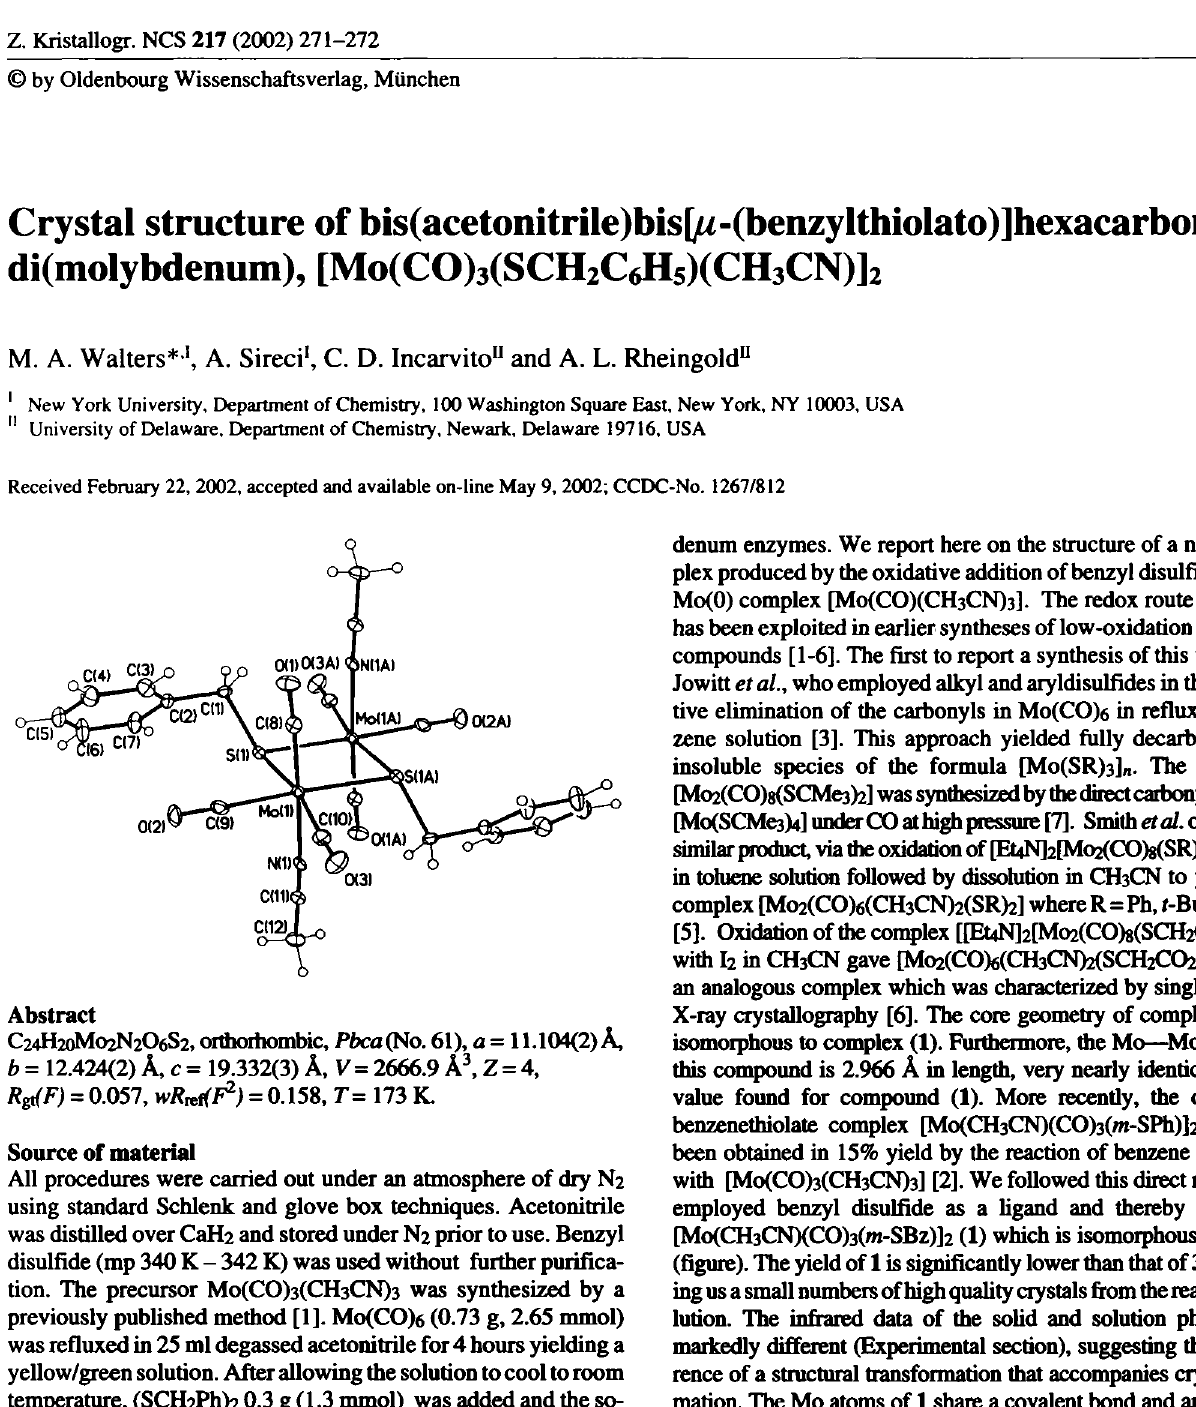
Table 1. Data collection and